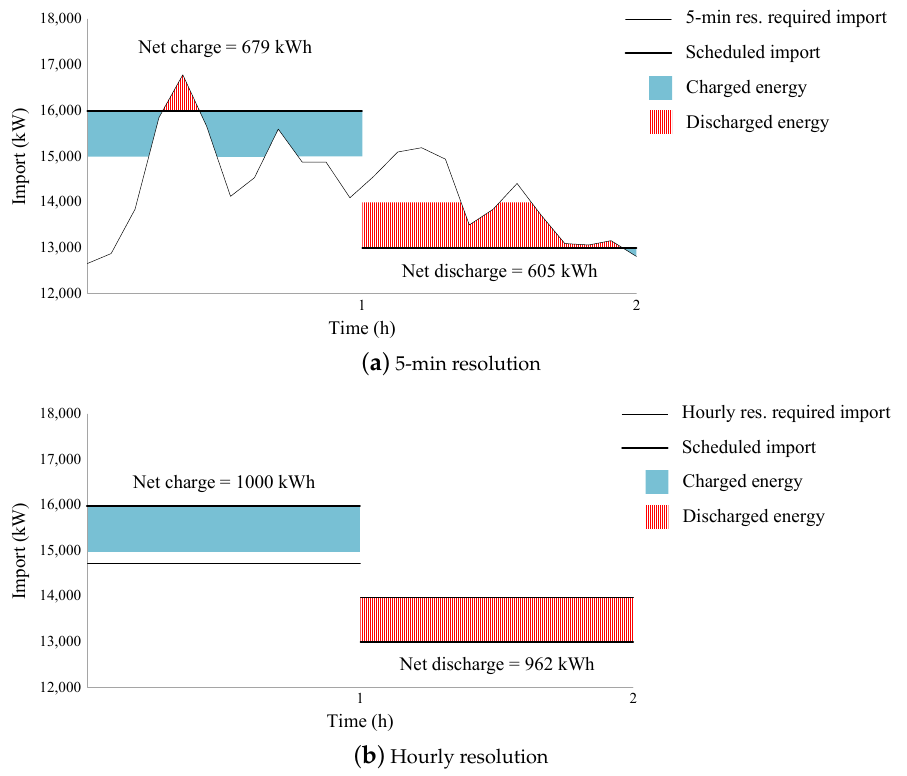
Figure 14. Charged and discharged energy of a 1 MW BESS for the sample period shown in Figure